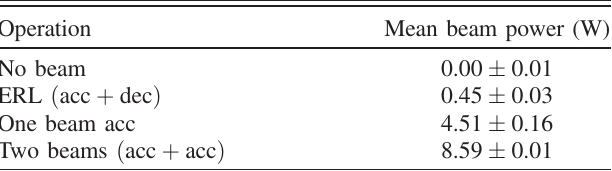
TABLE III. Mean values of the beam power with uncertainties of the distribution at the four S-DALINAC operation